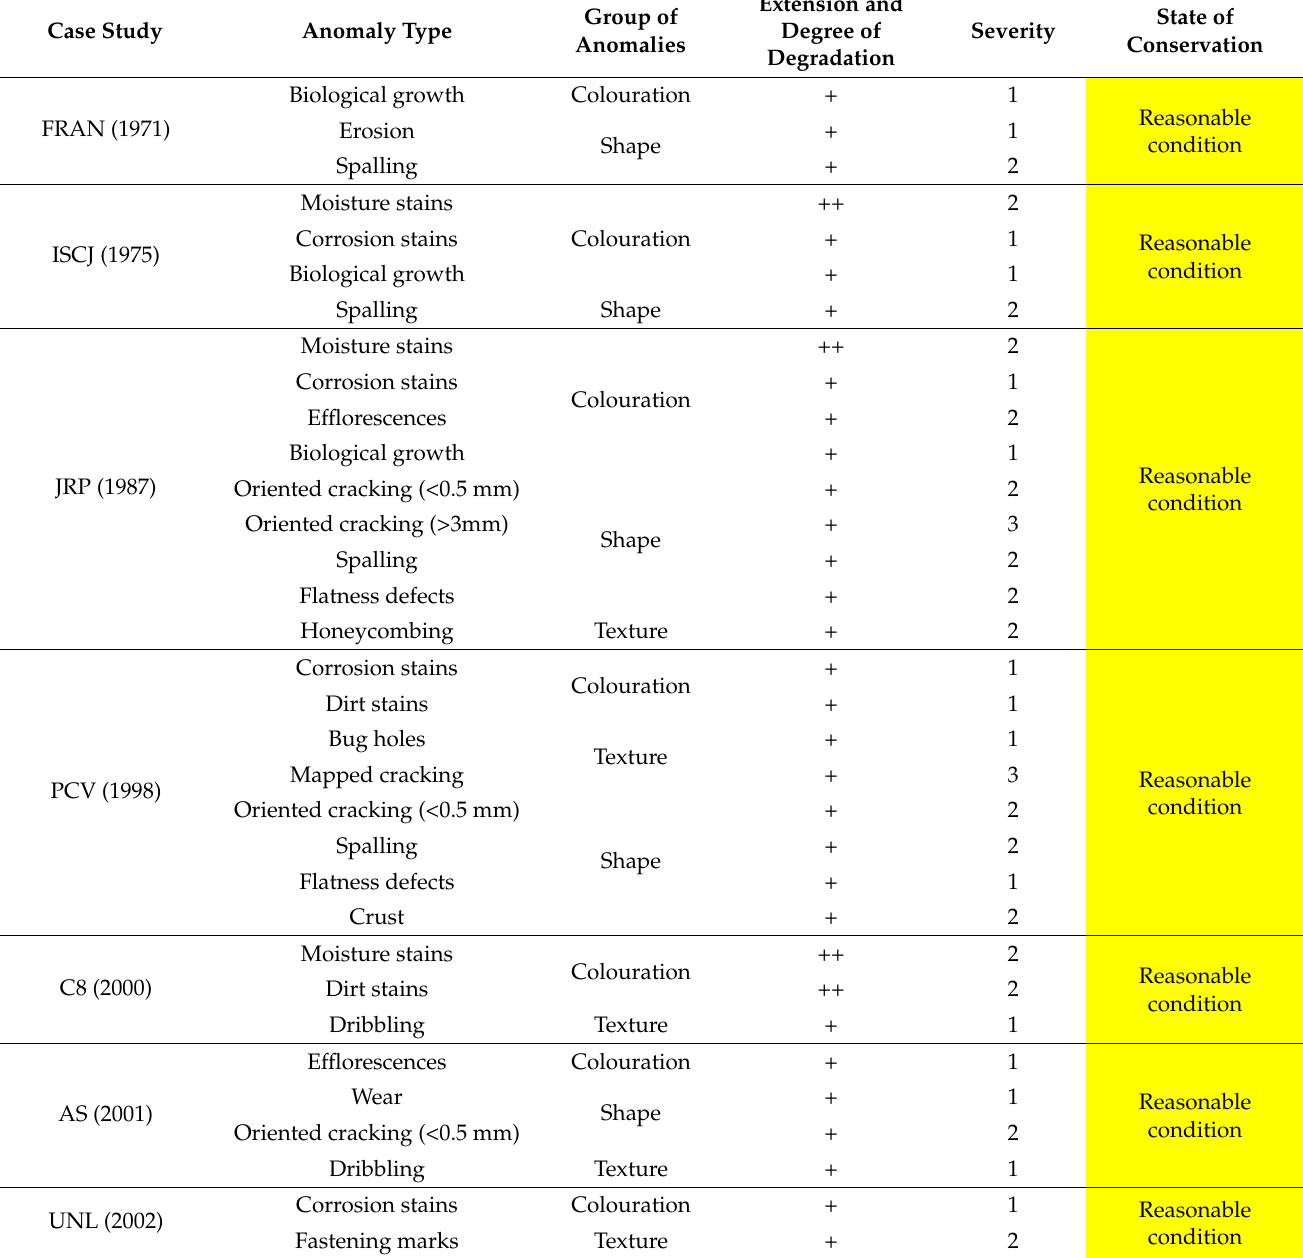
Table 12. State of conservation classification for architectural concrete of RCBs (colour code according to Table 4). Case